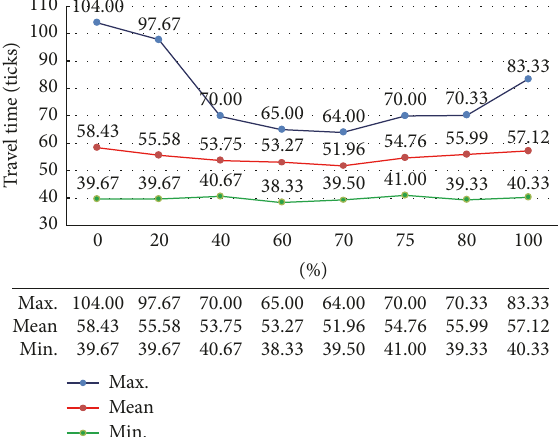
Figure 11: Statistics of travel time under different penetration rates of connected vehicles (road_1a).